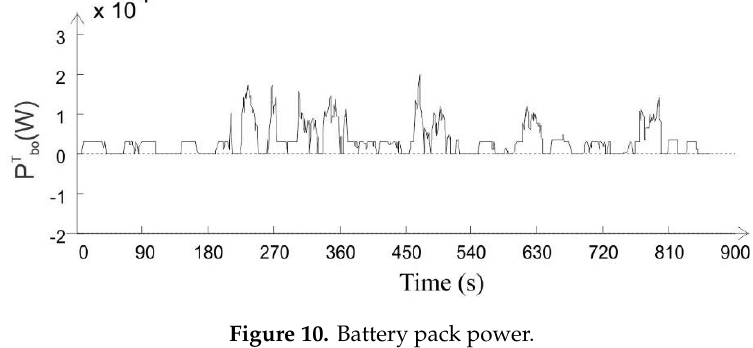
Figure 10. Battery pack power.